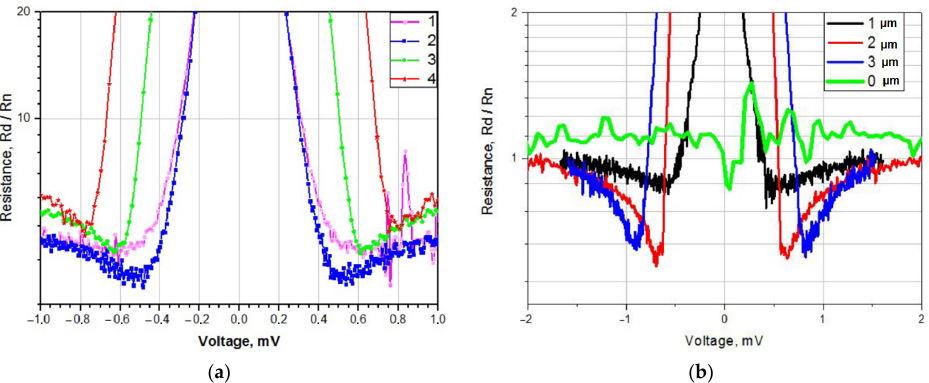
Figure 7. Dynamic resistances of four samples of series connection of two SINIS structures [32]: ( a ) different volumes of superconducting aluminum (1, 2, 3, and 4 correspond to the description in the text above); ( b ) different distances between the SIN junction and the normal metal trap.